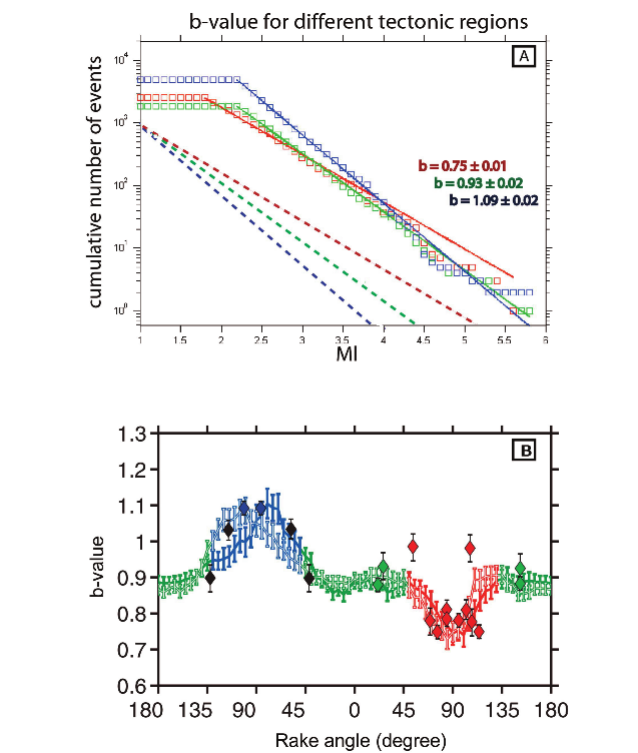
Figure 4. A) The frequency-magnitude distributions obtained from three tectonic regimes: normal (blue line, NR01); reverse (red line, sum of RV01, RV02, RV03, RV04) and strike-slip (green line, sum of SS01, SS02) and their normalized distributions (dotted lines), using a common a -value